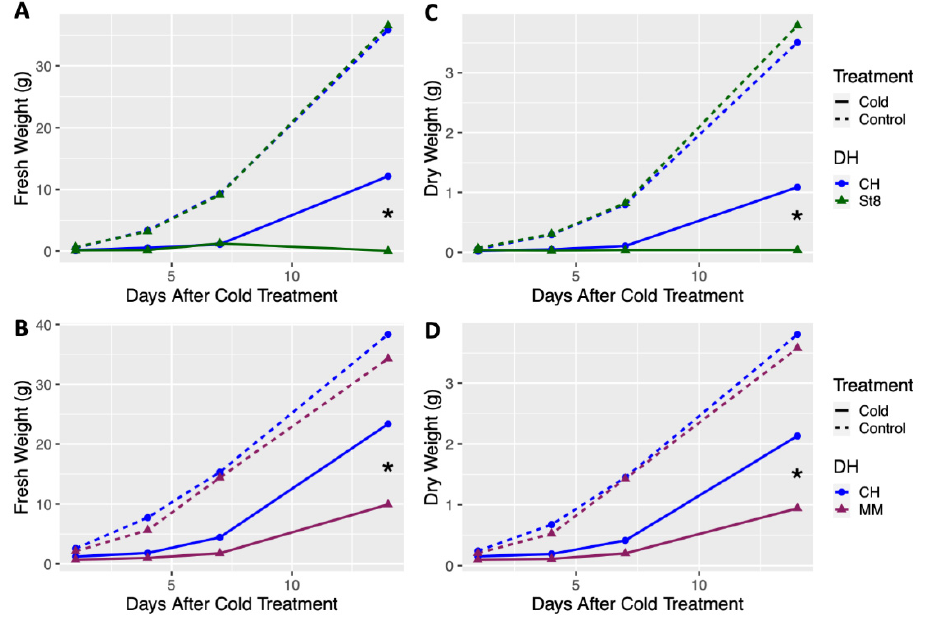
Figure 1. Least-square means of fresh and dry weight of doubled haploid (DH) ‘Chipper’ (CH) versus DHs ( A , C ) ‘Straight 8’ (St8), ( B , D ) ‘Marketmore 76’ (MM), plotted over timepoints at 1, 4, 7, and 14 days after cold treatment. Plants were grown in a greenhouse at 28 °C for 10 days then plants were either treated at 4 °C for 5.5 h at a light intensity of 270 µmol·s − 1 ·m − 2 (Cold) or remained in the greenhouse (Control). Plants were harvested by cutting just above the cotyledon. Each DH was compared to CH within each timepoint and treatment. * indicates significant difference between DHs based on Tukey’s HSD ( p < 0.05).